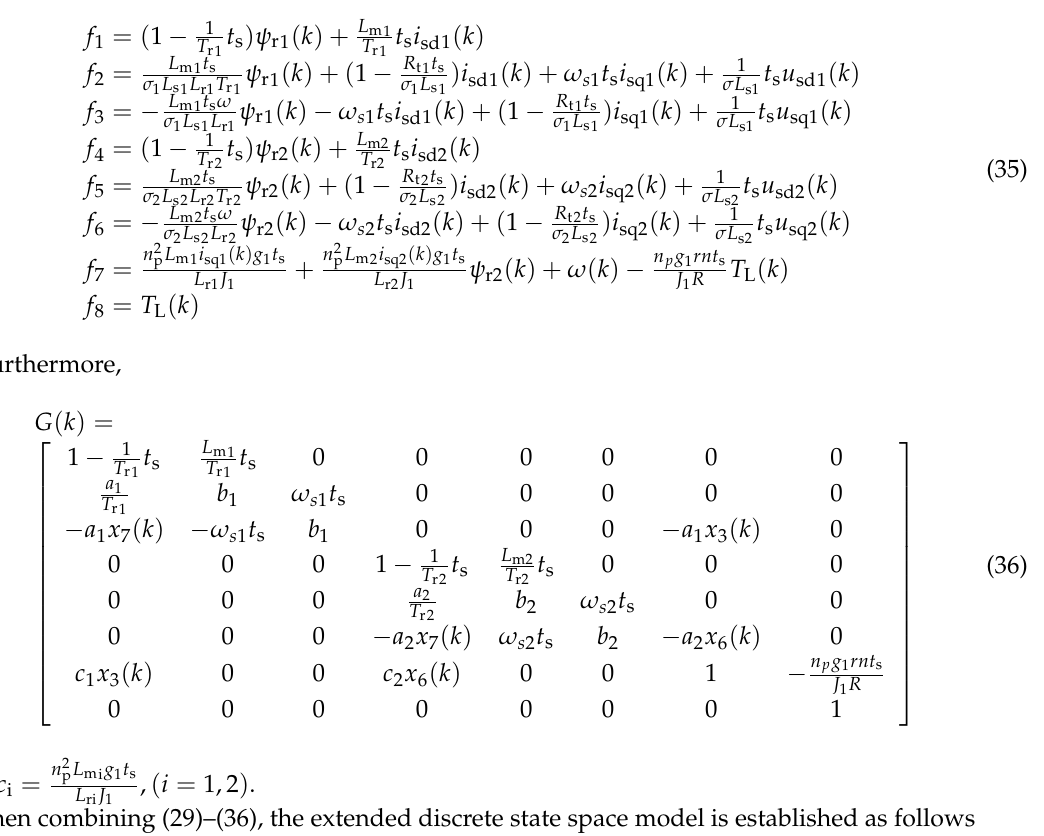
T . The scheme of EFK is shown in Figure L